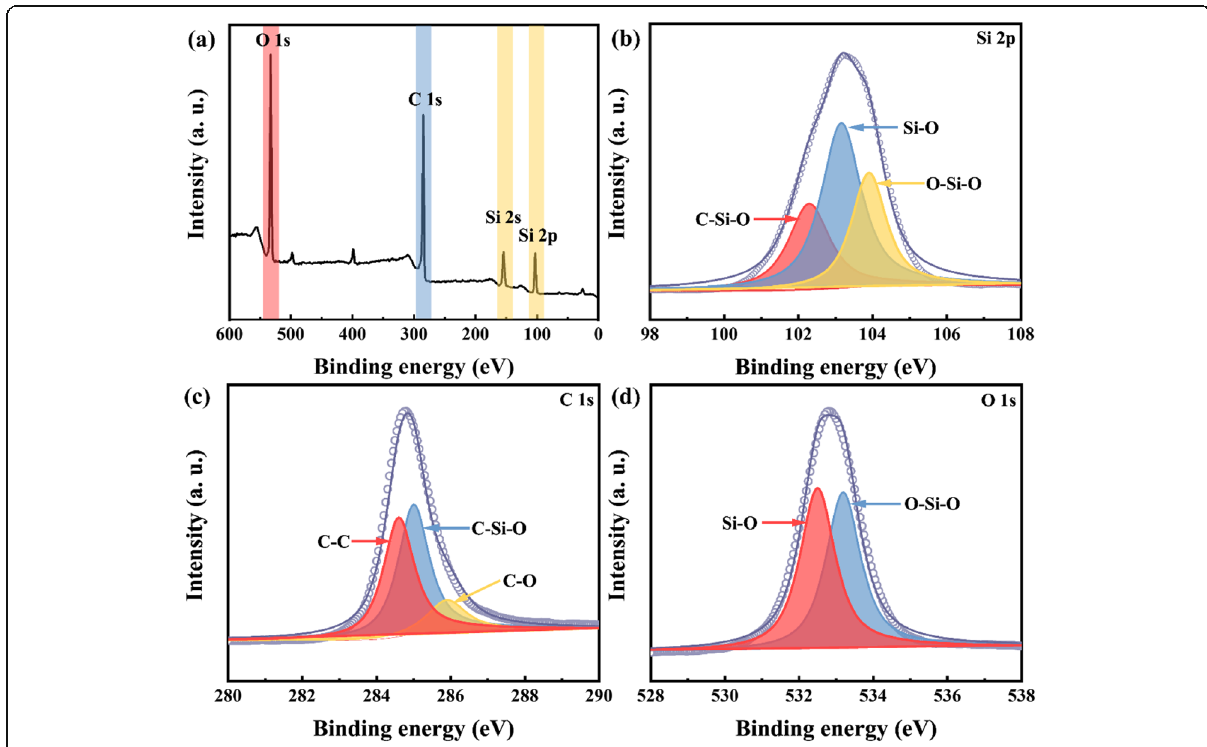
Fig. 3 The XPS spectra of HPSCs. a The survey spectrum. b The fitted Si 2p peak. c The fitted C 1s peak. d The fitted O 1s peak